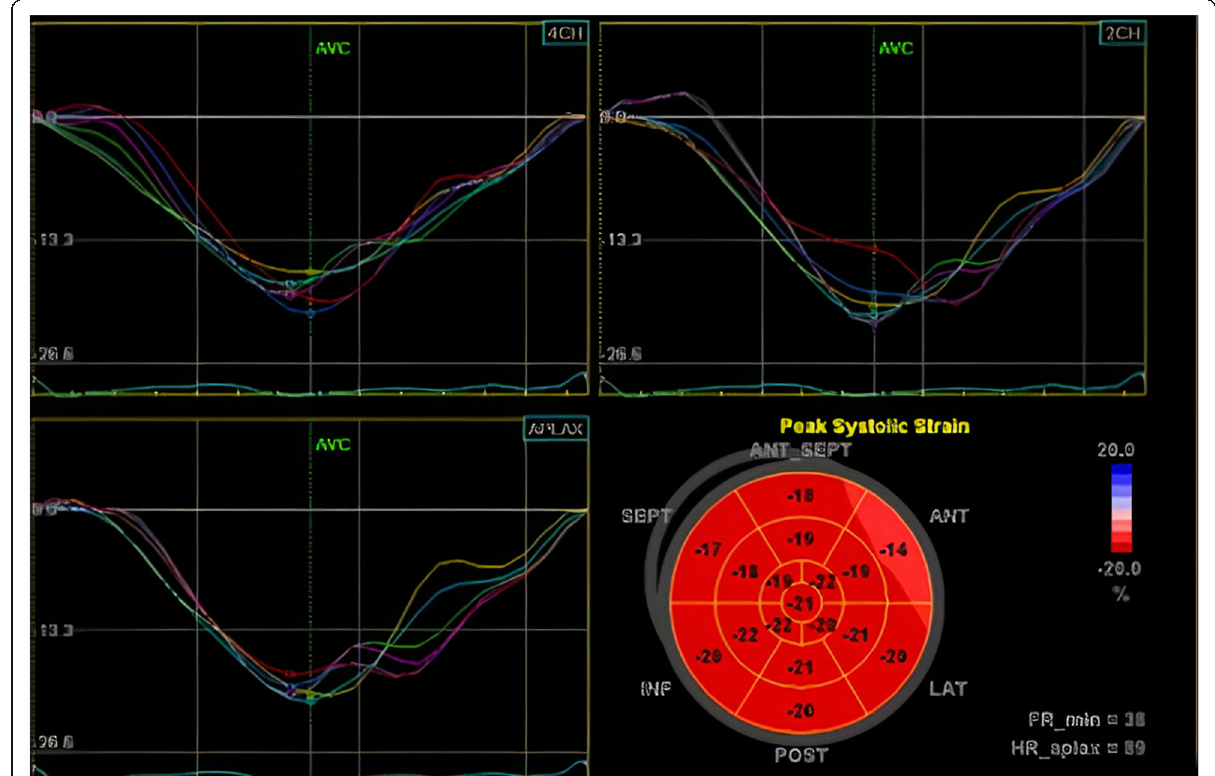
Fig. 3 Bull ’ s eye map of each segment with strain